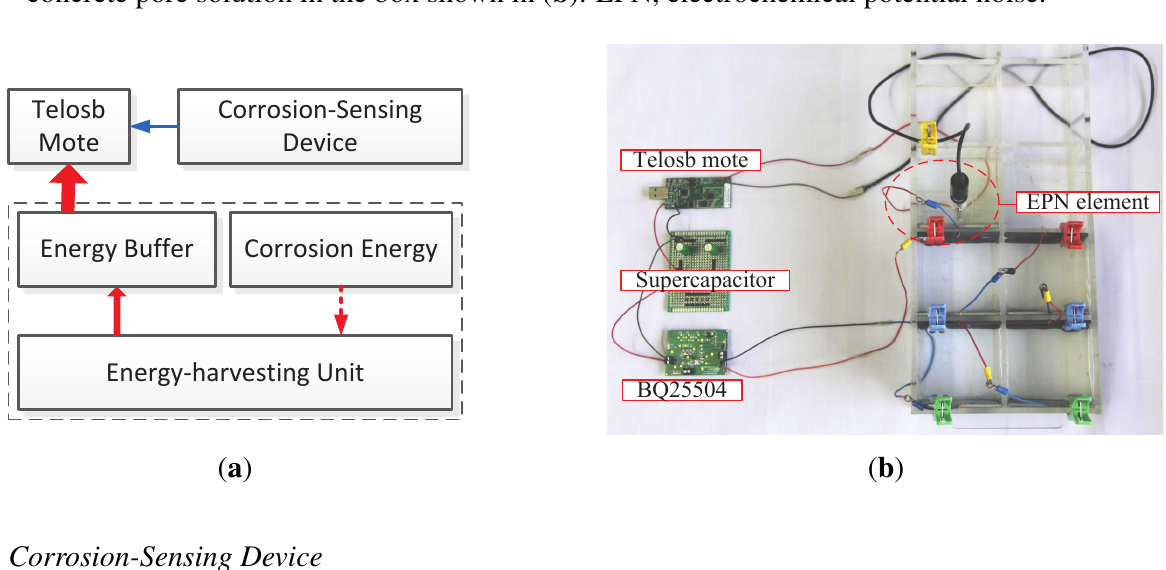
Figure 4. The architecture of the EPS sensor mote shown in ( a ) and the testbed with the concrete pore solution in the box shown in ( b ). EPN, electrochemical potential